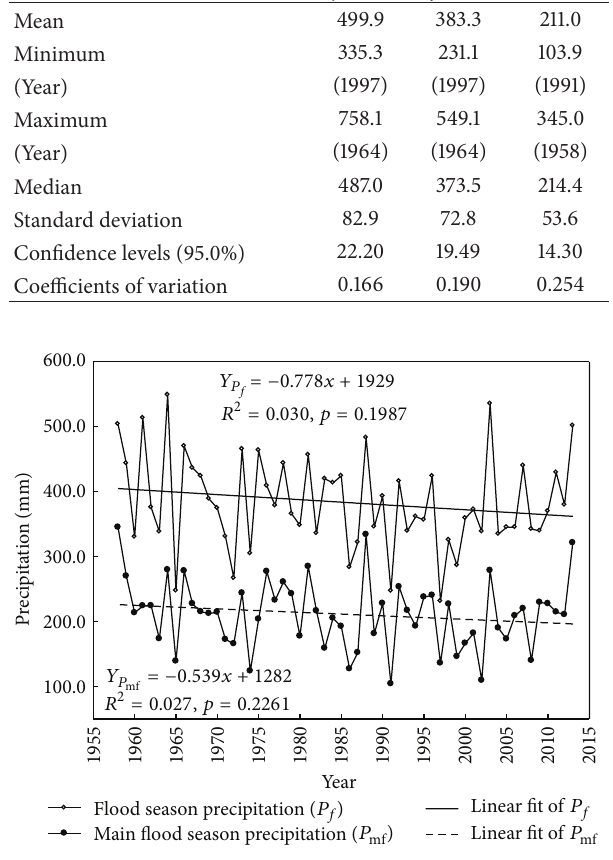
Figure 2: Mean annual flood season and main flood season precip- itation in the middle reaches of the Yellow River during